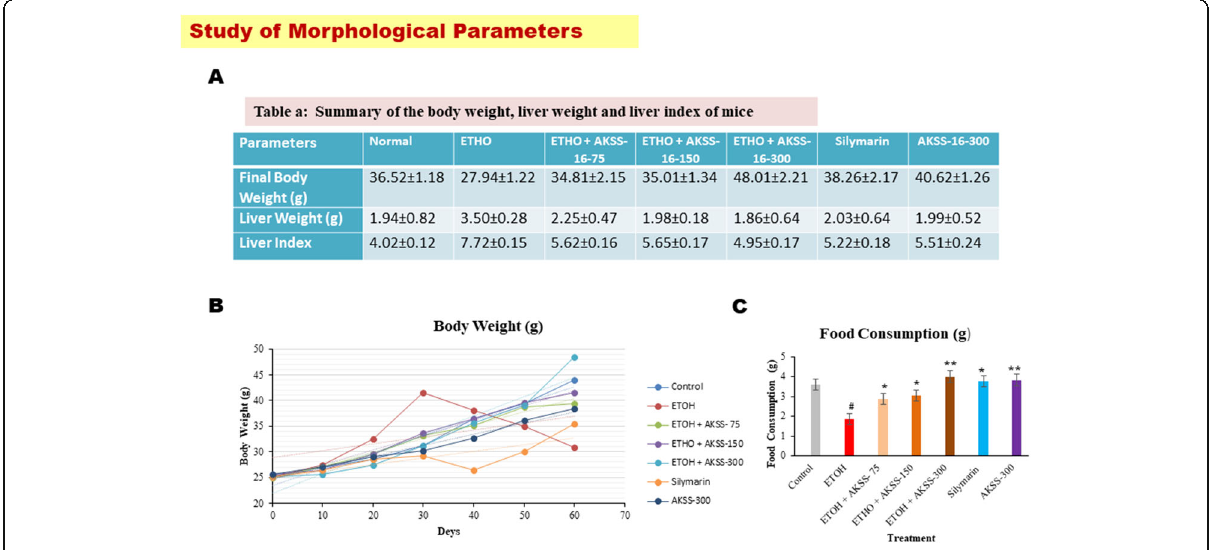
Fig. 2 Study of the morphological parameters. A Table showed summary of the body weight, liver weight and liver index in mice, B Day wise body weight, C Mean food consumption. The values are expressed as the mean ± SEM. Significantly different from control # p < 0.001 and significantly different from ethanol * p < 0.05, ** p < 0.001using analysis of variance (ANOVA) followed by Dunnett ʼ s Multiple Comparison